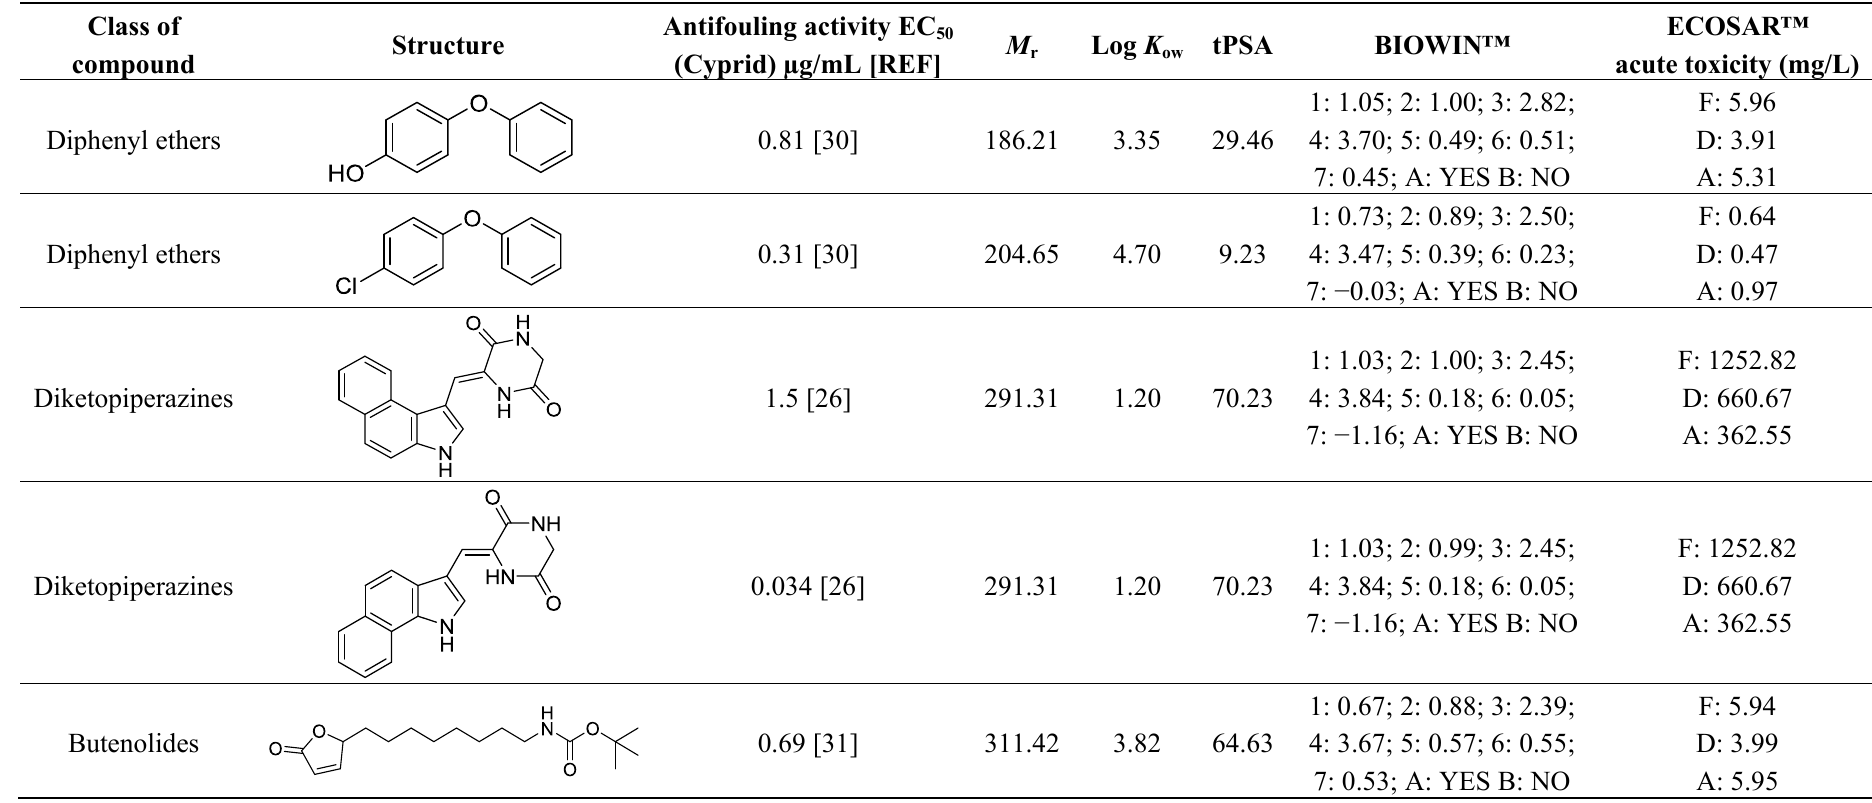
Table 6. Synthetic compounds of M < 400 with anti-fouling properties. EC = effective concentration at which 50% of larval settlement was r 50 prevented; M = molecular weight; tPSA = total polar surface area; Log K = log of water/octanol partition coefficient. All log K r ow were calculated using KOWWIN™. BIOWIN™ models: 1-linear, 2-non-linear, 3-ultimate, 4-primary, 5-linear MITI, 6-non-linear MITI, 7-anaerobic; Criteria A-model 2 or 6 > 0.5 and model 3 > 2.2; Criteria B-model 3 “weeks” or faster and model 5 > 0.5. ECOSAR™: F = fish, D = daphnid, A = green